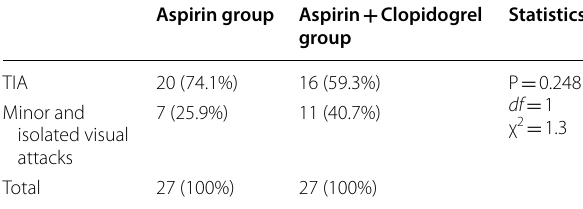
Table 2 Comparison of TIA type in study groups Aspirin group Aspirin Clopidogrel + group